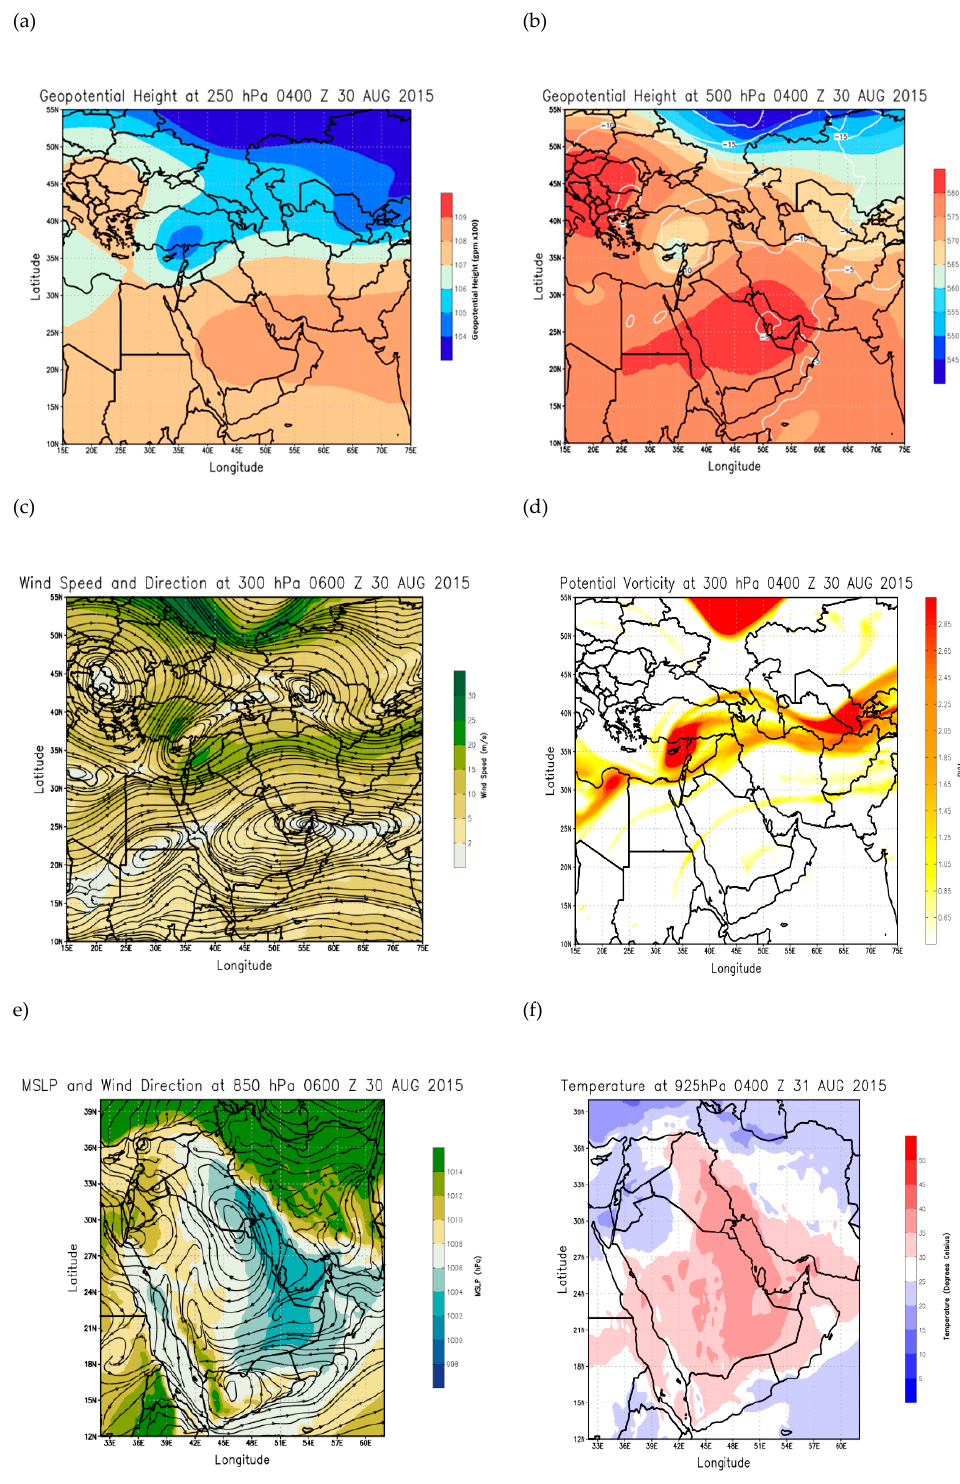
Figure 2. ECMWF ERA5 re-analyses on 30 August 2015 of: Geopotential height at 0400UTC at 250 hPa ( a ) and at 500 hPa ( b ), wind speed (colors) and wind direction (streamlines) at 300 hPa at 0600UTC ( c ), potential vorticity at 300 hPa at 0400UTC ( d ), mean sea level pressure (colors) and wind direction at 850 hPa at 0600UTC ( e ). ( f ) Temperature at 925 hPa on 31 August 2015 at 0400UTC. White contours on (b) are isocontours of ERA5 temperature at 500 hPa every 5 ◦